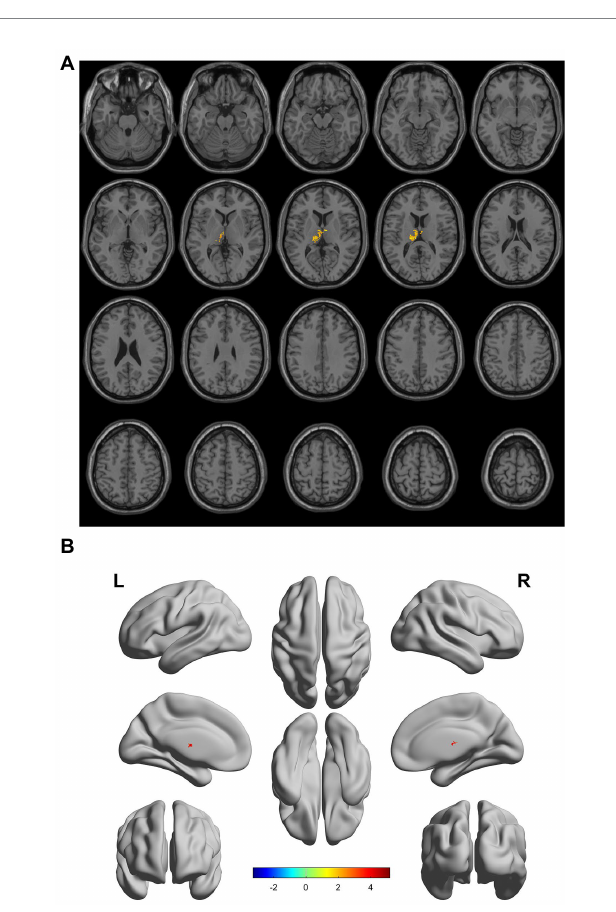
FIGURE 5 (A, B) Compared with the subcortical ischemic vascular disease (SIVD)- vascular cognitive impairment no dementia group, the distribution of gray matter atrophy changed in the SIVD-vascular dementia group. Orange-yellow shows the areas of